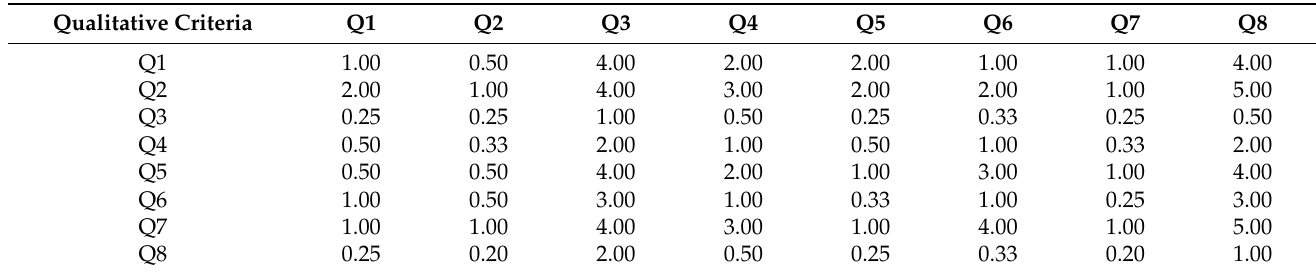
Table 6. Domination matrix of qualitative criteria of PV. Own